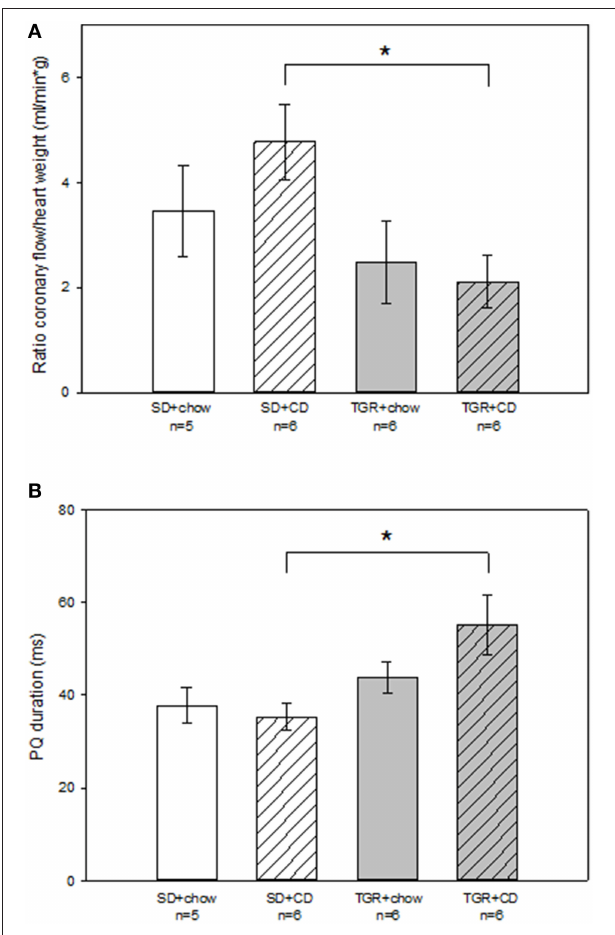
FIGURE 3 | Epicardial mapping analysis of isolated-perfused hearts of male wild type Sprague Dawley rats (SD) and transgenic rats (TGR), overexpressing Ang(1-7) after a 5 month feeding period with either standard chow alone or simultaneously chow and cafeteria diet (CD). Isolated-perfused rat hearts were prepared according to Langendorff-technique. Epicardial mapping was performed as previously described by Dhein et al. (1993). (A) Coronary flow was related to heart weight and is given as coronary flow to heart weight ratio. TGR + CD rats showed significantly reduced coronary flow to heart weight ratio compared to SD + CD rats. (B) Furthermore, PQ duration of rat hearts was measured. CD in combination with an overexpression of Ang(1-7) led to a significant prolongation of PQ duration in comparison to SD + CD rats. Data expressed as means ± SEM of n experiments. Significant changes between groups are indicated by an asterisk ( p < 0.05 ). Coronary flow to heart weight ratio and PQ duration were analyzed by Kruskal-Wallis followed by pairwise comparison using the Dwass-Steele-Chritchlow-Fligner.